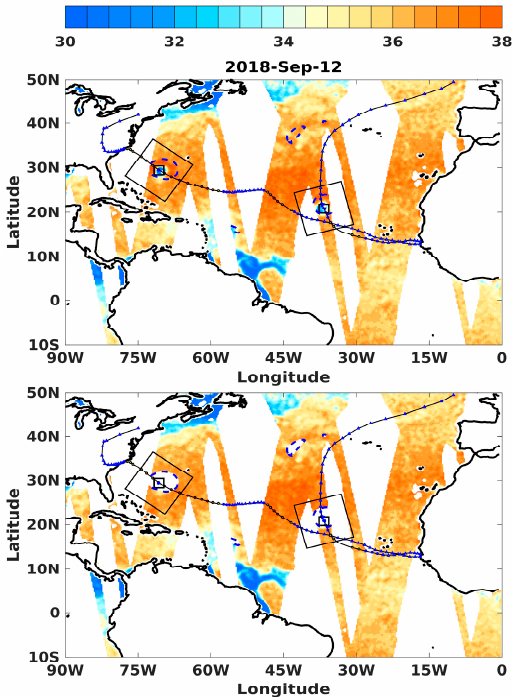
Figure 1. Distribution of sea surface salinity (psu) on 2018 September 12, from SMAP swath daily data (L2C) with (lower panel) and without (upper panel) the high surface wind (>15 m s − 1 ; dashed blue line) associated SSS removed. Two TC tracks are Florence (left) and Helene (right), respectively. The larger (smaller) squares show the 10° × 10° (2° × 2°) TC-centered boxes. Larger squares are rotated so that the translation direction is along the x-axis and pointing to the left.